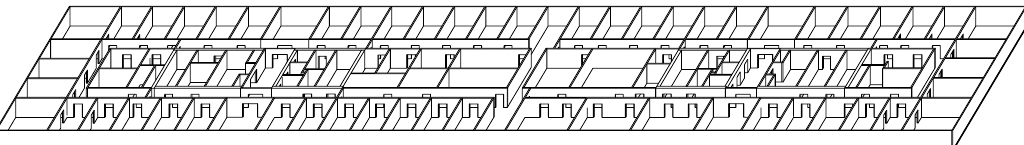
Figure 4. The 3D BIM model used for